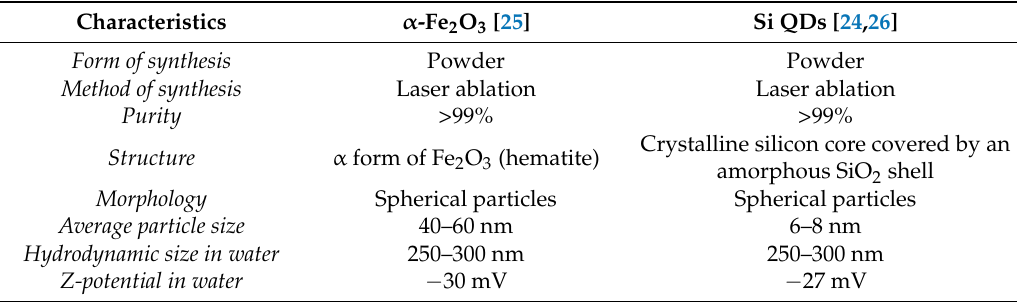
Table 1. Physicochemical characteristics of α -Fe 2 O 3 and Si quantum dot (QD) nanoparticles as described previously